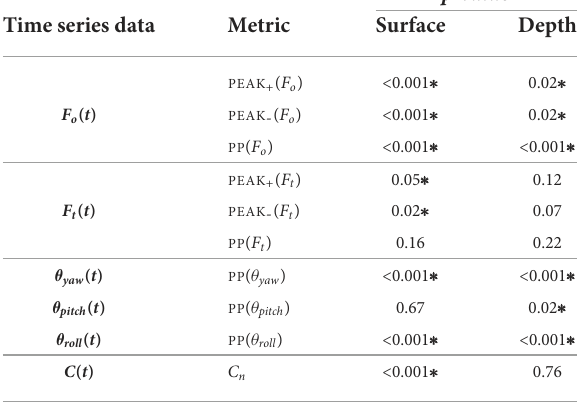
TABLE 2 Statistical results for motion-based, physical contact and vision-enabled force metrics.